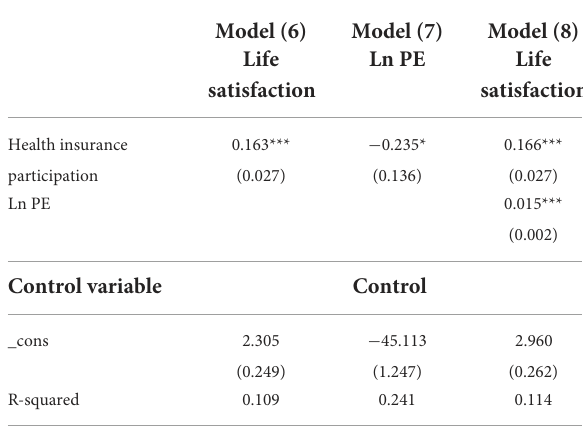
TABLE 3 Intermediary test